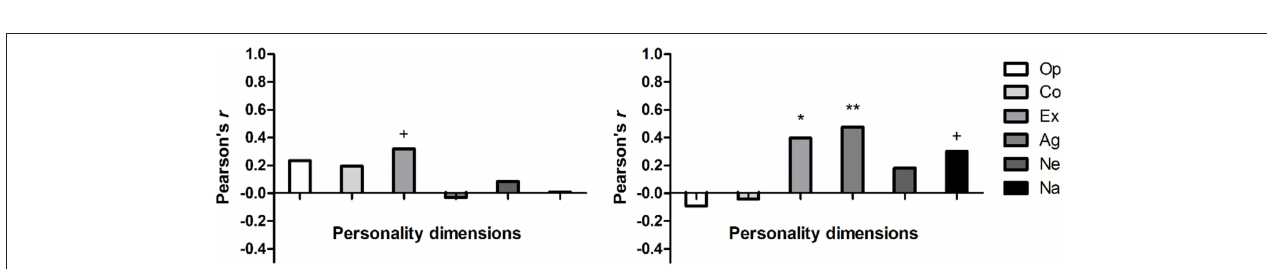
FIGURE 4 | Correlation coefficients between nickname users’ self-reported personality dimensions and participants’ personality judgments based on nicknames: intrasexual (left: women rating women, right: men rating men). Op, Openness to experience; Co, Conscientiousness; Ex, Extraversion; Ag, Agreeableness; Ne, Neuroticism; Na, Narcissism. + p < 0.10, * p < 0.05, ** p <